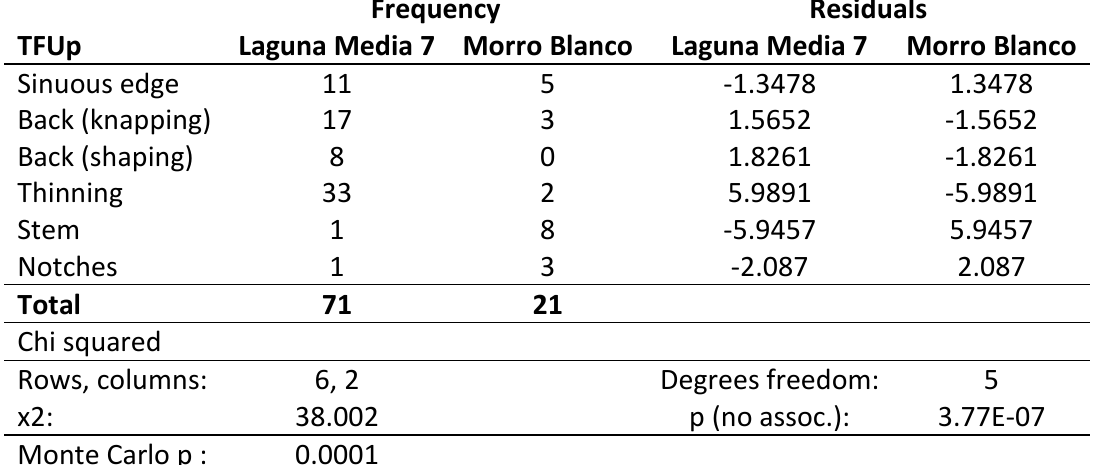
Table 5. Frequencies and normalized residuals for the Prehensile TFU from Laguna Media 7 and Morro Blanco - x 2 and Monte Carlo results.